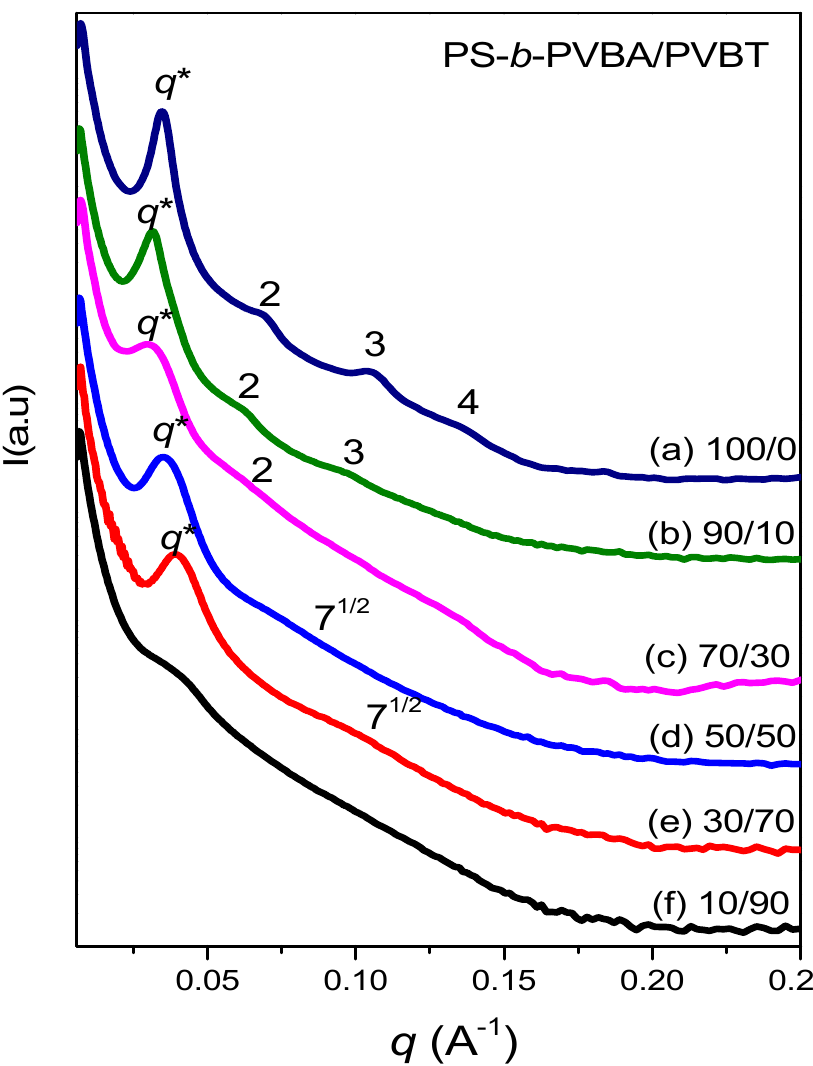
Figure 9. SAXS analyses of PS- b -PVBA/PVBT blends, after thermal annealing at 180 °C, at compositions of ( a ) 100/0; ( b ) 90/10; ( c ) 70/30; ( d ) 50/50; ( e ) 30/70 and ( f ) 10/90.